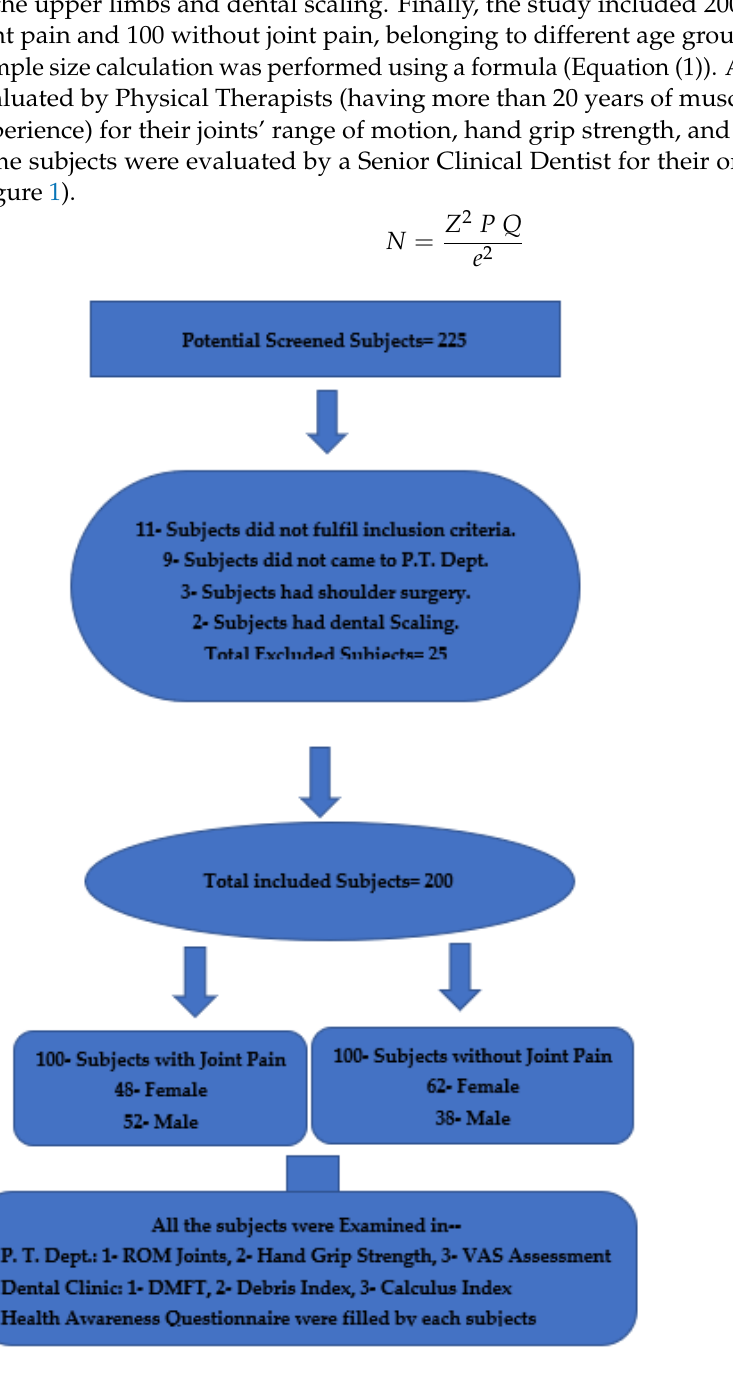
Figure 1. Participants’ flowchart.